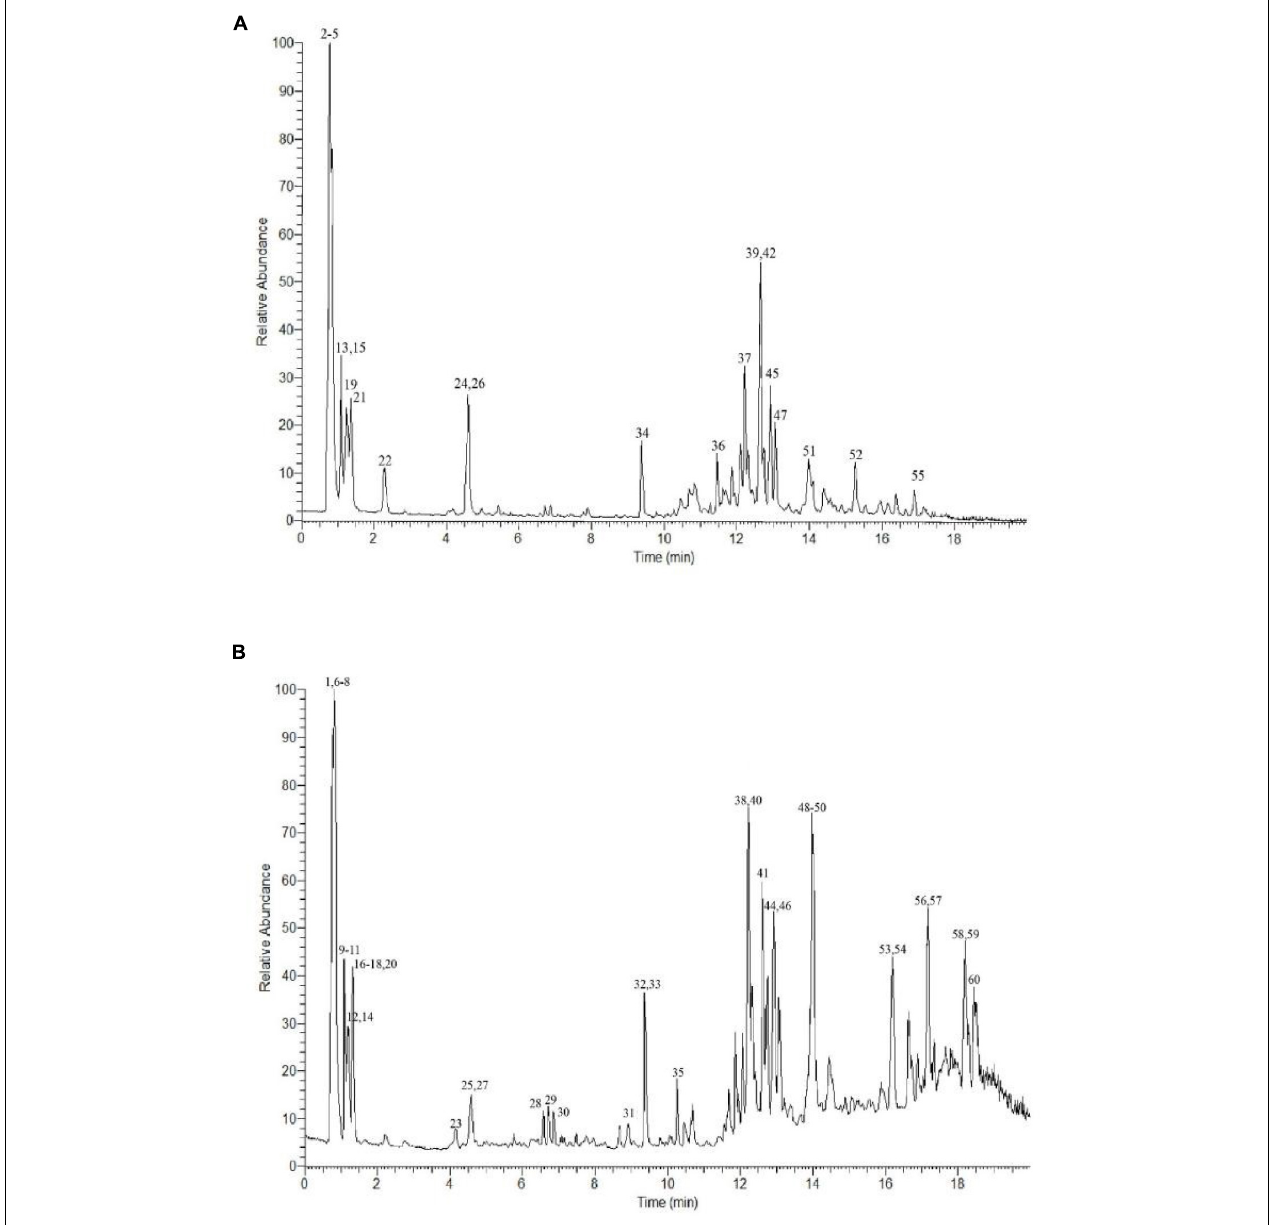
FIGURE 1 | UPLC-Q-Extractive Orbitrap MS total ion chromatogram of ion mode in P. vicina extract. (A) Positive. (B)